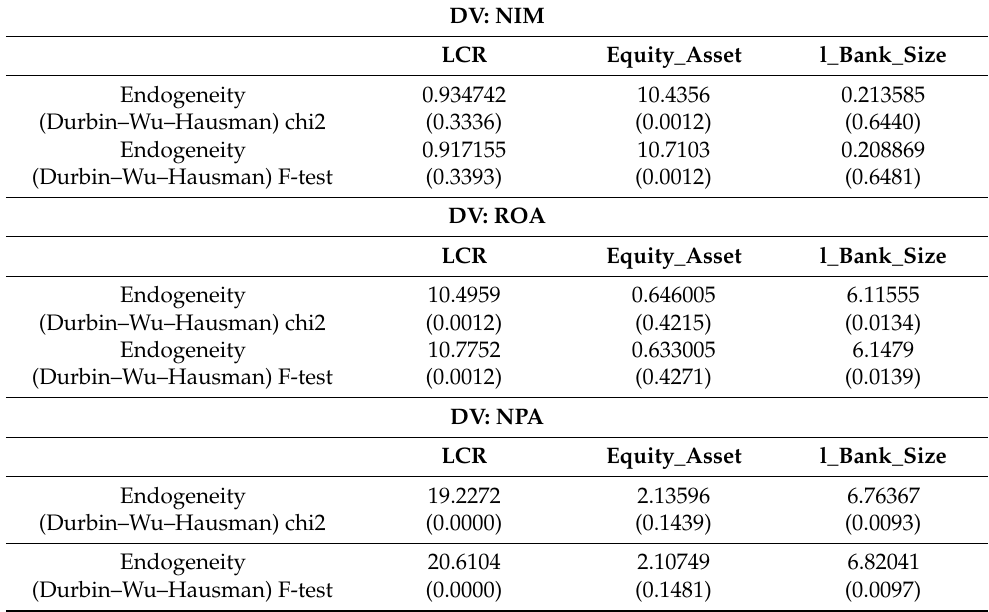
Table 7. Results for Endogeneity